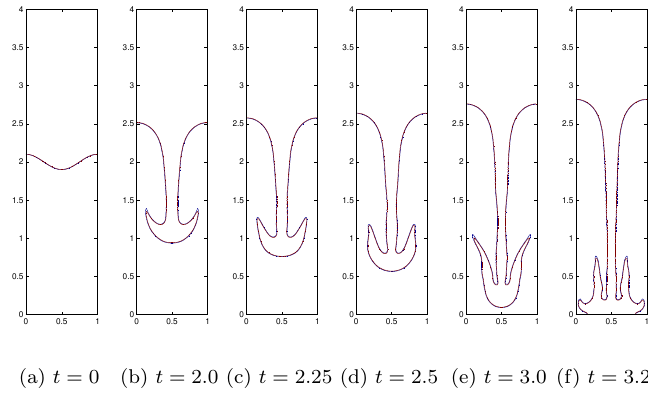
Figure 3. The interface of Problem 2 for Re = 1000 and At = 0 . 75.